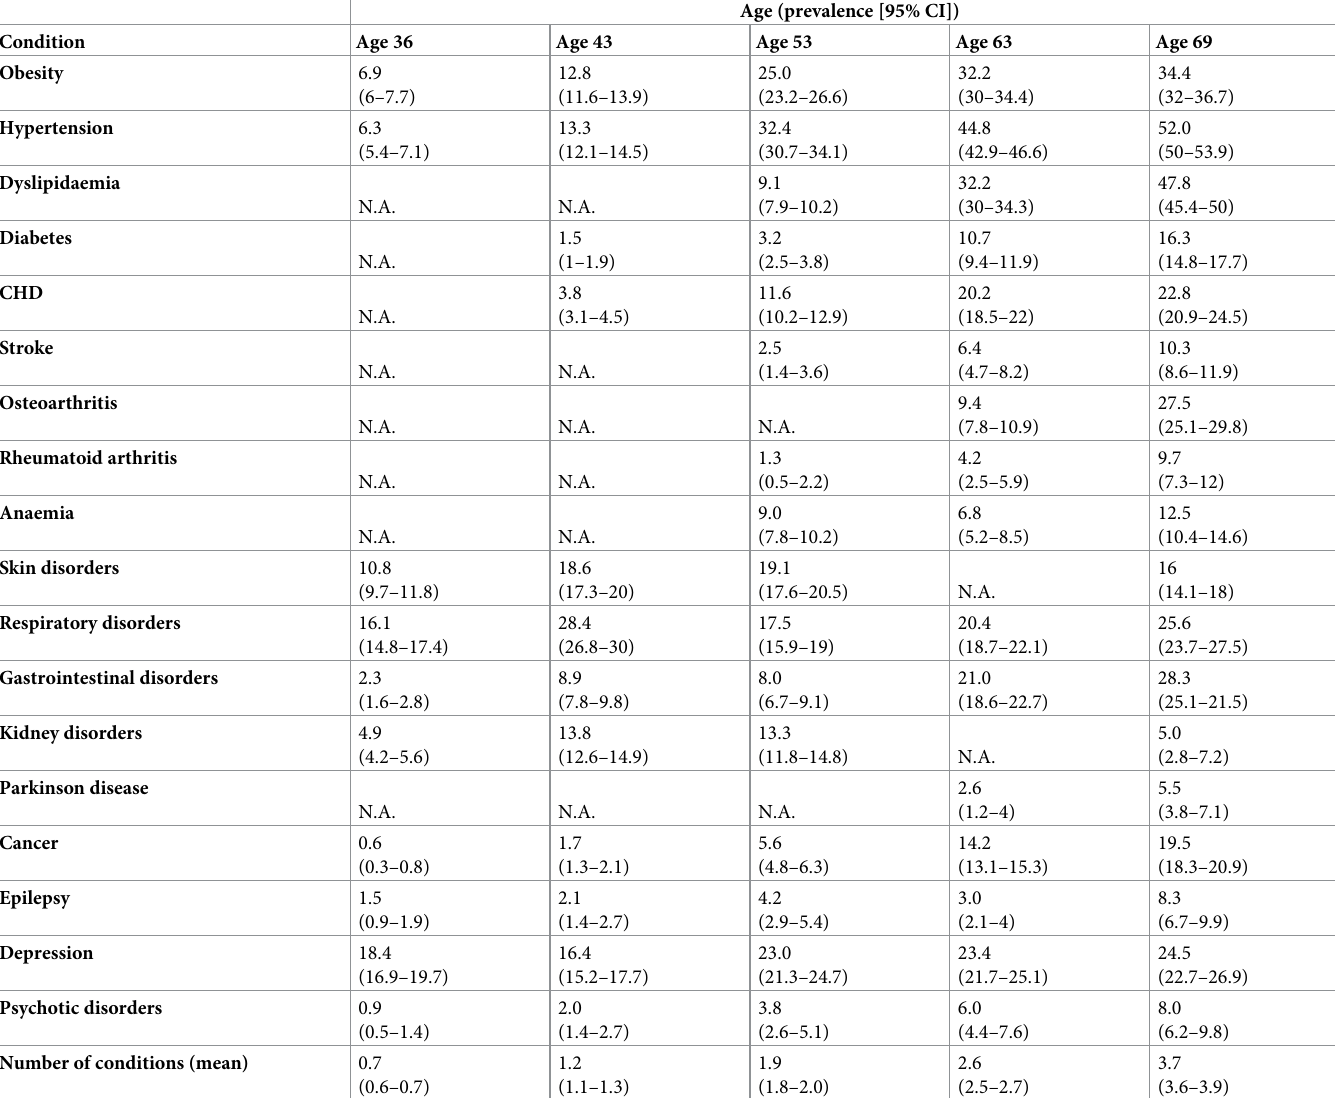
Table 1. Prevalence (%) of conditions and multimorbidity at each of the 5 age sweeps in 3,723 participants from the 1946 MRC